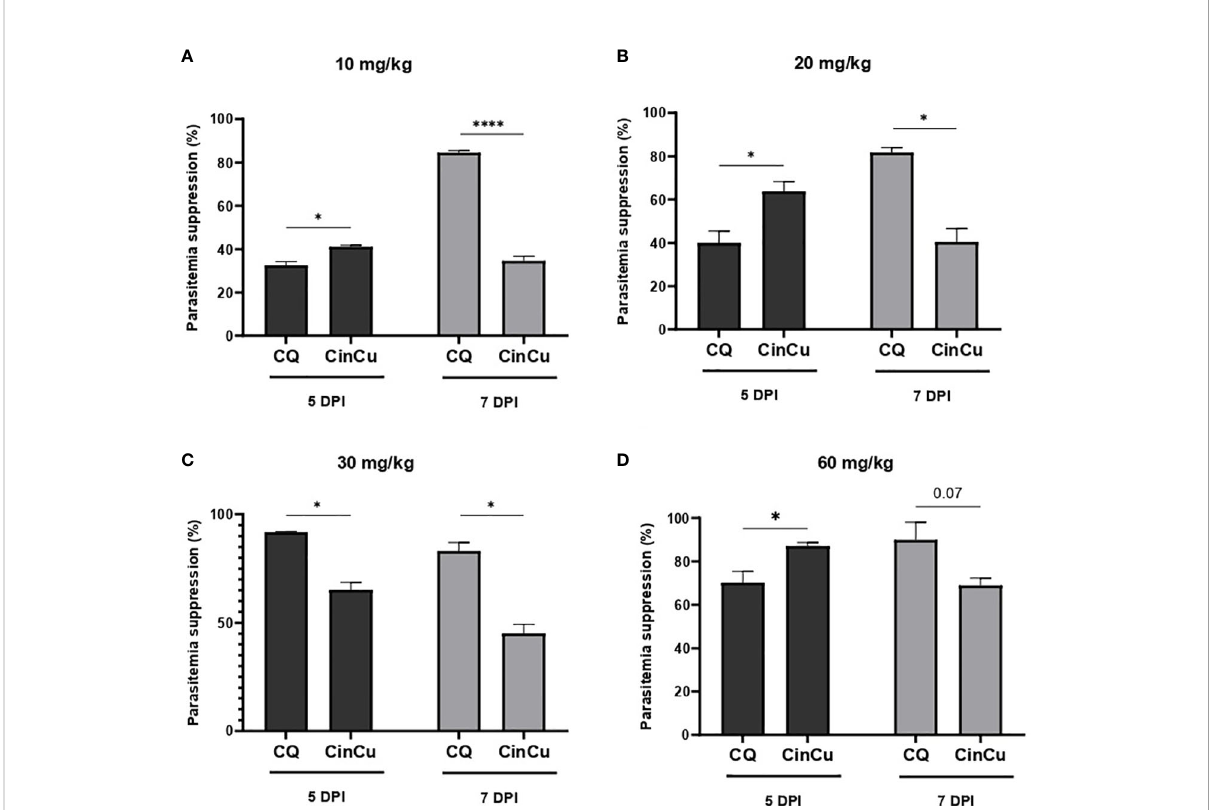
FIGURE 4 In vivo analysis of the CinCu and chloroquine effect on parasitemia suppression of P. berghei ANKA infection. The parasitemia suppression activity was evaluated on the fi fth and seventh days post-infection, after treatment with 10 mg/Kg (A) , 20 mg/Kg (B) , 30 mg/Kg (C) , and 60 mg/ Kg (D) of CinCu and chloroquine. Results are presented as mean ± SD of three independent experiments. * p<0.05; ****